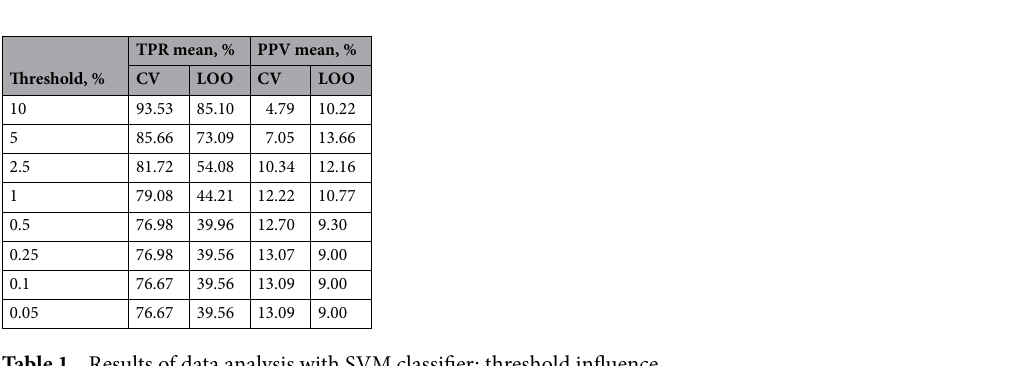
Table 1. Results of data analysis with SVM classifier: threshold